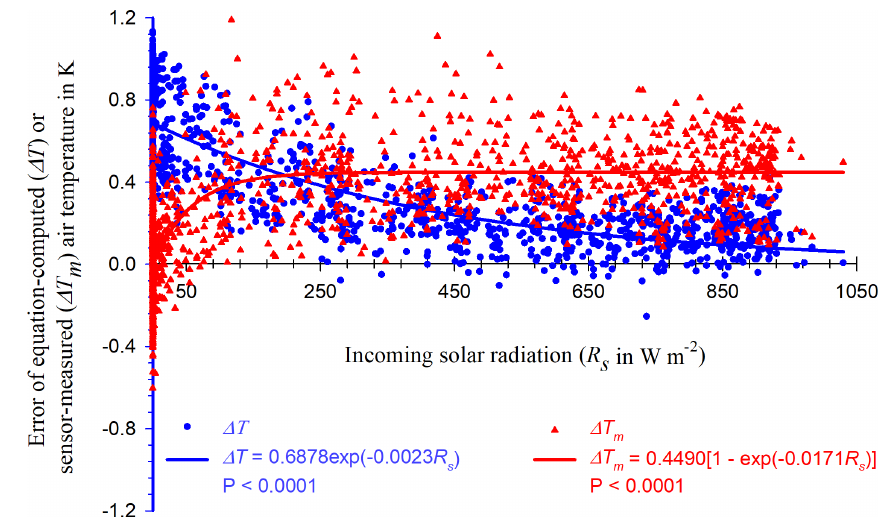
Figure 6. Errors in equation-computed and sensor-measured air temperature ( T ) with incoming solar radiation. (cid:49)T is equation-computed T minus RTD-measured T , where RTD denotes a precision platinum resistance temperature detector inside a fan-aspirated radiation shield. (cid:49)T m is sensor-measured T minus RTD-measured T , where the sensor is an HMP155A air temperature and humidity probe inside a wind- aspirated radiation